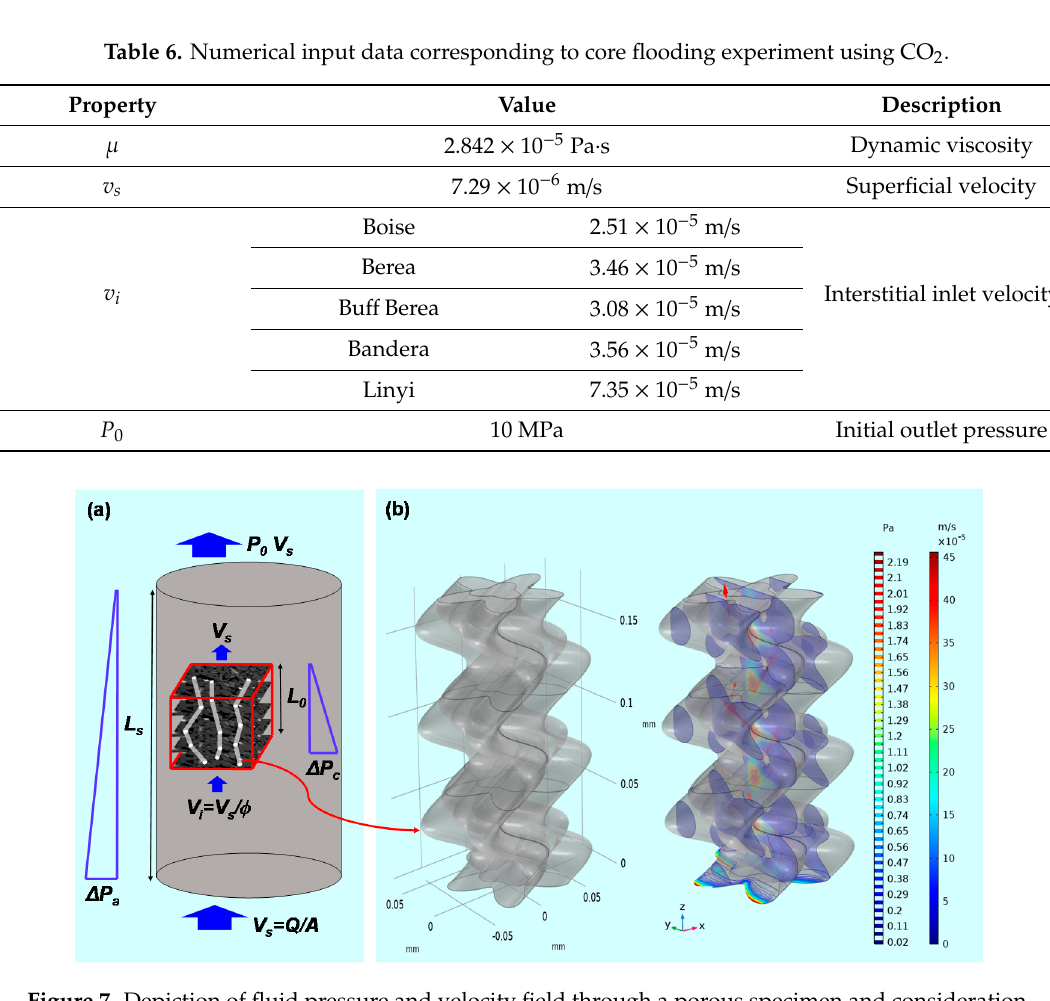
Figure 7. Depiction of fluid pressure and velocity field through a porous specimen and consideration of a micro-CT image volume fraction. ( a ) Illustration of the experimental condition of steady state flow under a constant pressure gradient. Boundary notation explains the parameters for adopting Darcy’s law in both the experiment and numerical simulation. ( b ) Computed pressure and velocity field in the pore channel model of Berea sandstone.